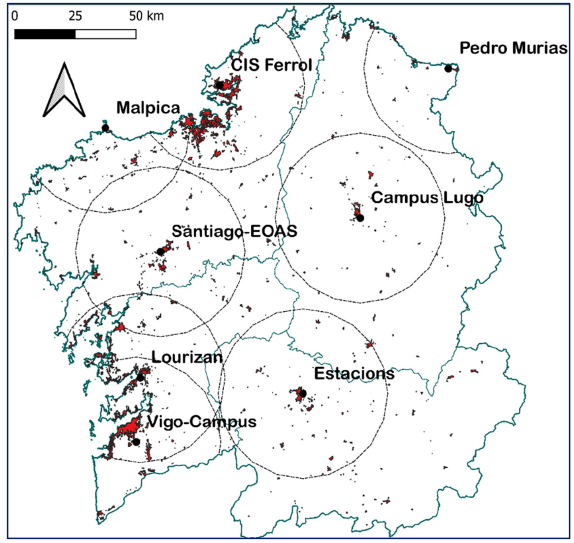
Figure 1. Selected weather stations and population areas of influence [19].